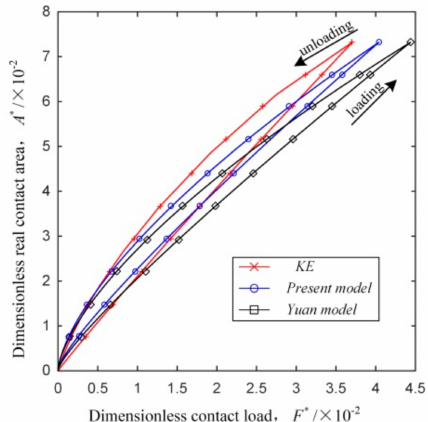
Figure 7. The comparison between the present model, the Kogut and Etsion (KE) model and the Yuan